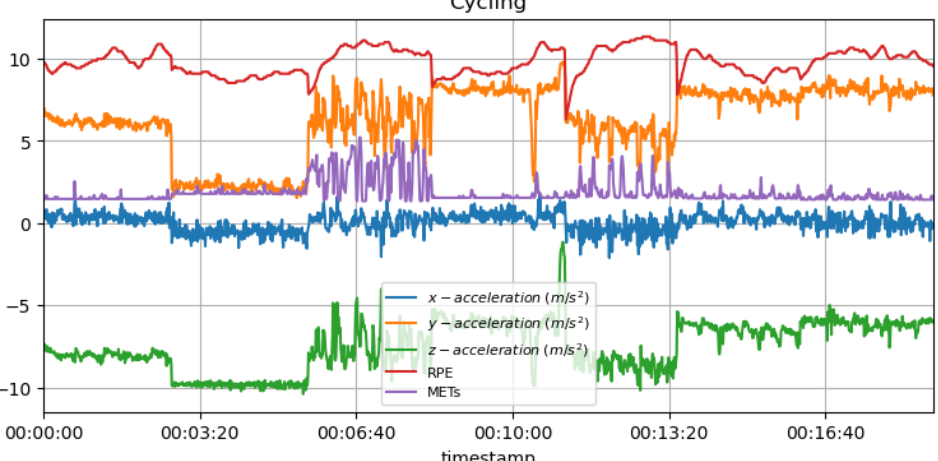
Figure 18. METs and RPE variations for cycling activity with acceleration